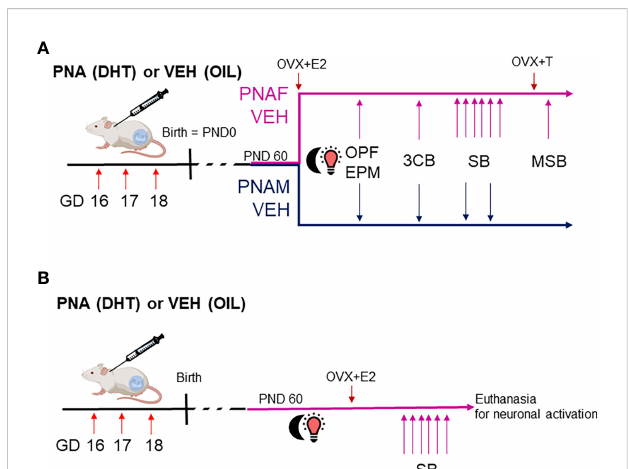
FIGURE 1 Experimental design to study the effect of prenatal DHT exposure on sexual behaviors in male and female mice. In this study, we used two batches of mice. (A) The fi rst batch of mice was used to determine if male and female-typical sexual behaviors could be affected by prenatal androgen exposure (experiment 1 and 2). Dams were treated with either dihydrotestosterone (DHT) or oil vehicle (VEH) at gestational day (GD) 16, 17 and 18. After birth, the male and female offspring entered the experimental protocol at adulthood around postnatal day 60 (PND60). PNAF and VEH females (magenta line) were ovariectomized and implanted with a silastic capsule containing estradiol in order to normalize hormonal status and arti fi cially induced receptivity (OVX+E2). PNAM and VEH male mice (blue line) were left intact. Then, the animals entered a series of behavioral procedures to test their anxiety-like behavior and locomotion within an open- fi eld (OPF) and an elevated-plus maze (EPM) tests, their abilities to discriminate a sexual partner within a three-compartments box partner preference test (3CB) and their typical sexual behavior (SB,